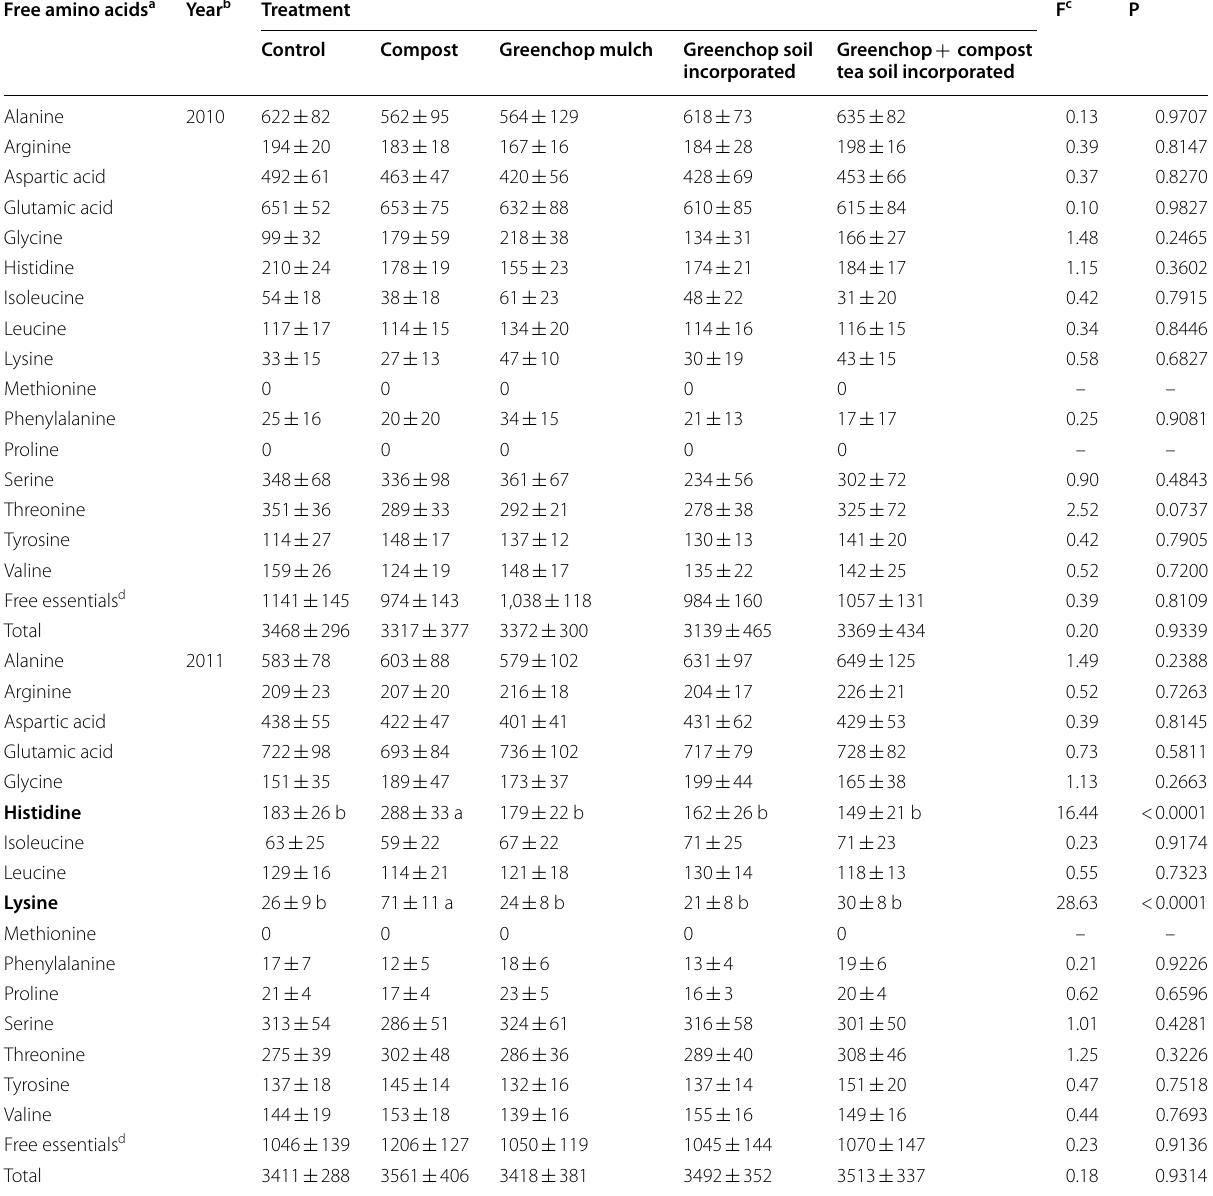
Table 3 Mean ( SE) concentrations of selected free amino acids in sugarcane leaf tissue (nanomoles/10 μl) from field plots amended ± with compost (605 kg/0.11-ha plot), greenchop mulch, greenchop that was soil-incorporated, and greenchop that was sprayed with compost tea then soil incorporated, and from control plots (all treatments received 119 kg/ha N fertilizer), Hidalgo Co. Texas, 2010